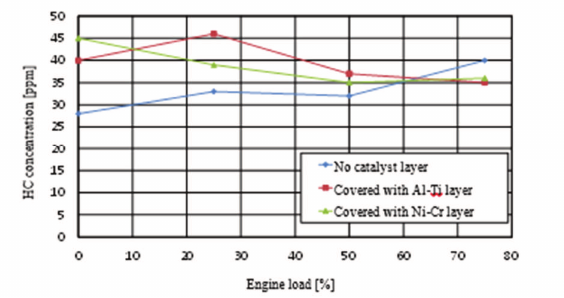
Fig. 2. The concentration of carbon monoxide as a function of engine load